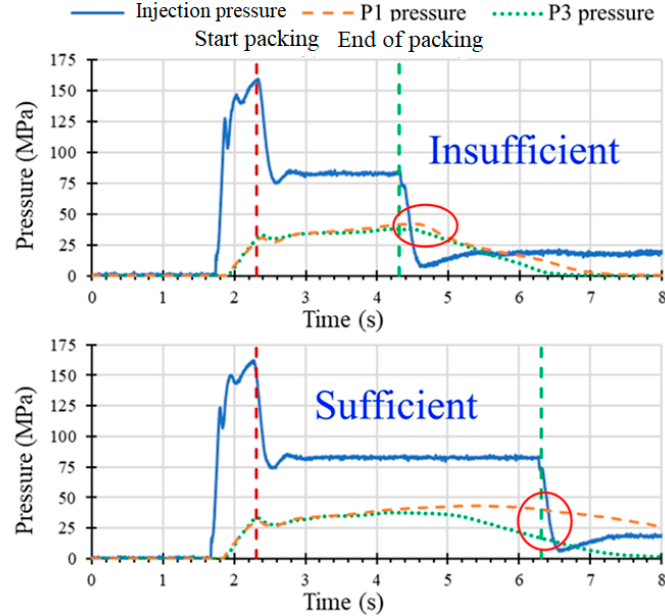
Figure 10. Determination of packing time: sufficient ( top ) and insufficient ( bottom ).